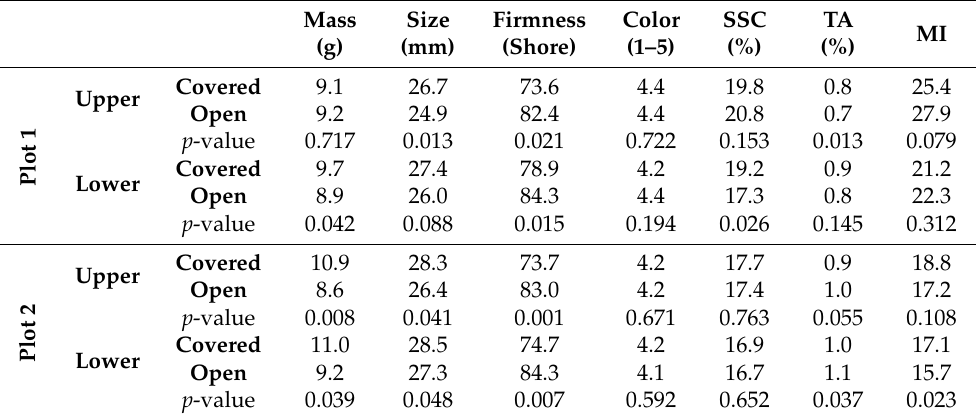
Table 2. Effect of the treatment (covered and open) and fruit position (upper and lower canopy) on fruit quality characteristics of ‘Santina’ sweet cherries, Plot 1 (season 2018/2019) and Plot 2 (season 2019/2020).